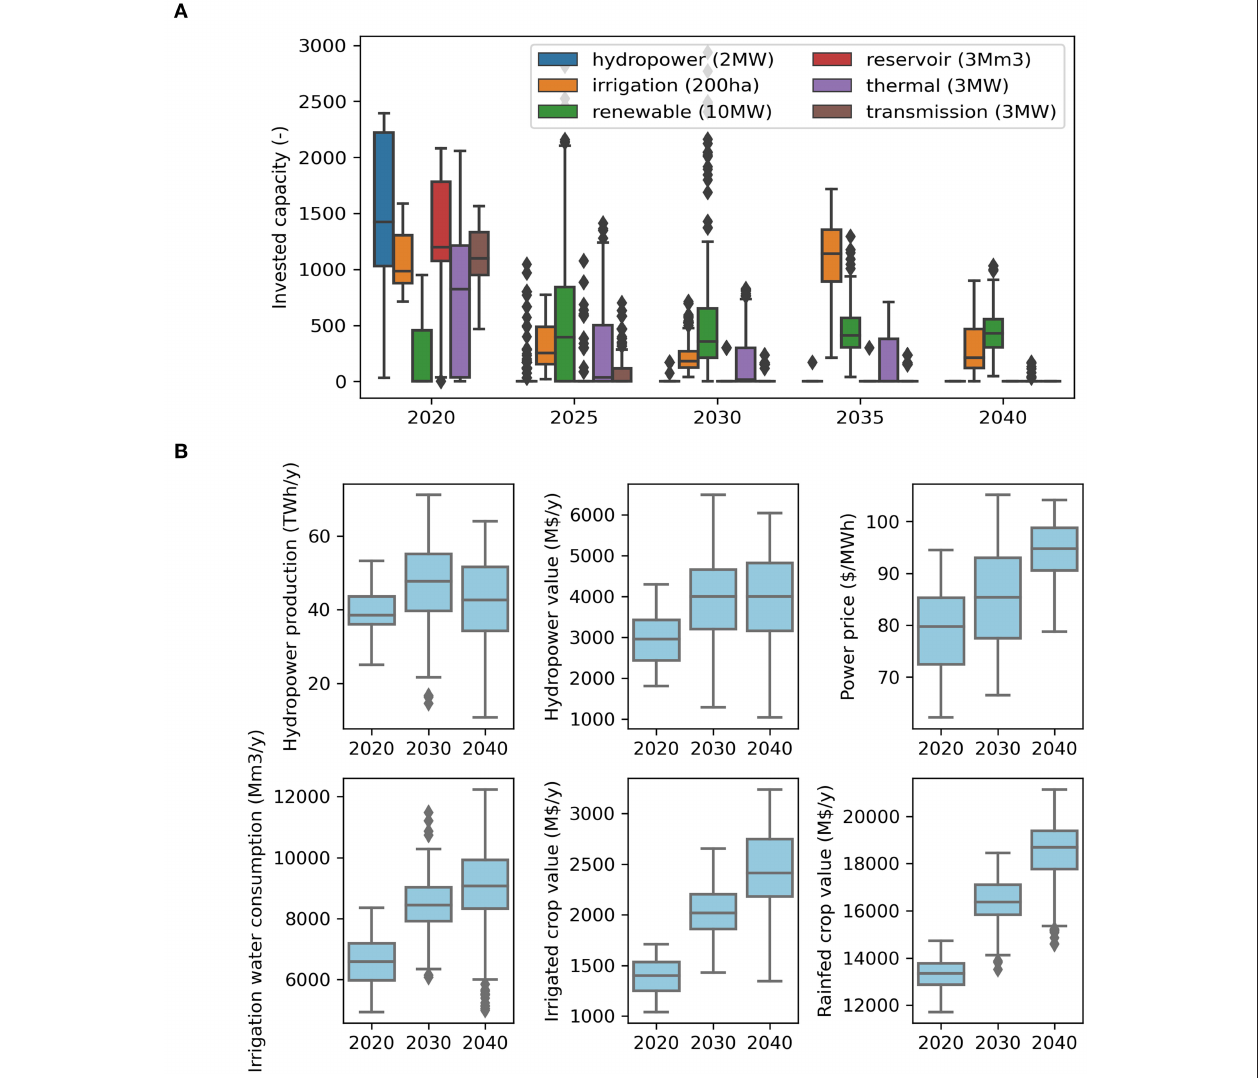
FIGURE 9 | Investment sequence (A) and evolution of key indicators (B) in the Zambezi River Basin for the nexus framework. Boxplots show the variability among scenarios. The box represents the quartiles Q1–Q3, the bar represents the median (Q2), the top whisker the highest datapoint within Q3 + 1.5*(Q3–Q1) and dots are values beyond